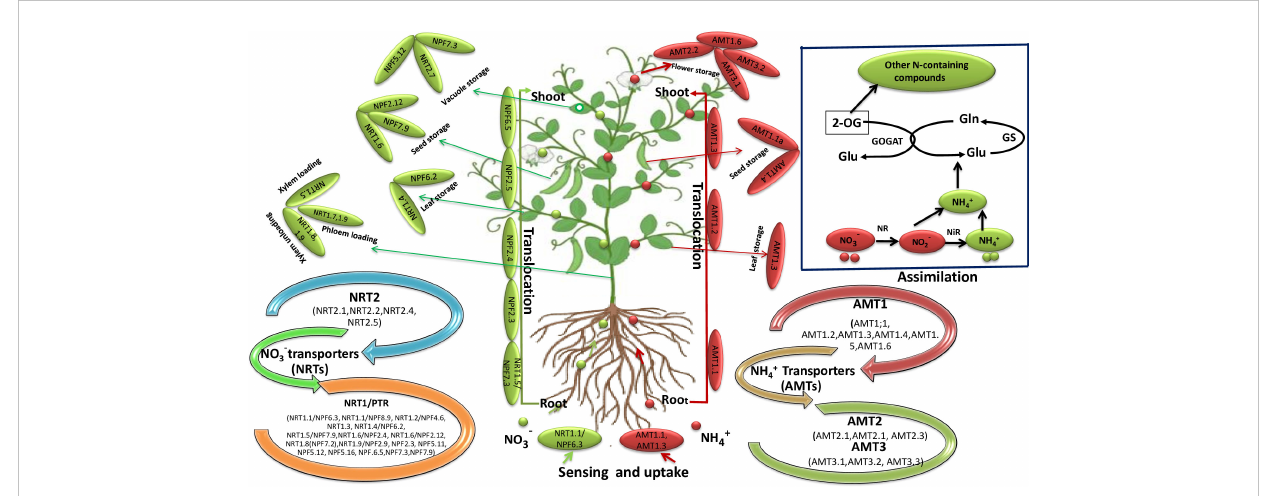
FIGURE 2 Schematic diagram showing the routes of NO 3 ¯ and NH 4+ sensing, transportation and accumulation in plants. The green dots and arrows denote the transport of NO 3 ¯ and the red dots and arrows indicates the transport of NH 4+ ions in plants. In the uptake process, NO 3 ¯ and NH 4+ enter the plant roots via NRTs and AMTs transporters respectively. For example, NRT1.1/NPF6.3/CHL1, AMT1.1 and AMT1.3 involved in the sensing of NO 3 ¯ and NH 4+ respectively. These transporter are localized in the plasma membrane of root cells. After uptake, NO 3 ¯ transported via NRT1.5/NPF7.3, NPF2.3, NPF2.4, NPF2.5 and NPF6.5 and NH 4+ via AMT1.1, AMT1.2 and AMT1.3 to the shoot through xylem. NRT1.5 is involved in NO 3 ¯ loading in the xylem, while as NRT1.8, NRT1.9 are involved in NO 3 ¯ unloading from the xylem. However, NRT1.7, NRT1.9 transport NO 3 ¯ into the phloem. Furthermore, NRT1.4/NPF6.2 and AMT1.3 mediates NO 3 ¯ and NH 4 + transport to the leaf/petiole. NO 3 ¯ accumulation within the leaf vacuole is mediated by NPF7.3, NPF5.12, and NRT2.7. AMT1.1, AMT1.2 and AMT1.3 mediates NH 4+ transoction from root to shoot. NRT1.6/NPF2.12, NPF7.9 and AMT1.1a, AMT1.4 is involved in the transportation of NO 3 ¯ and NH 4+ respectively in the seed where they accumulated in the vacuoles. NRT2.7 is a